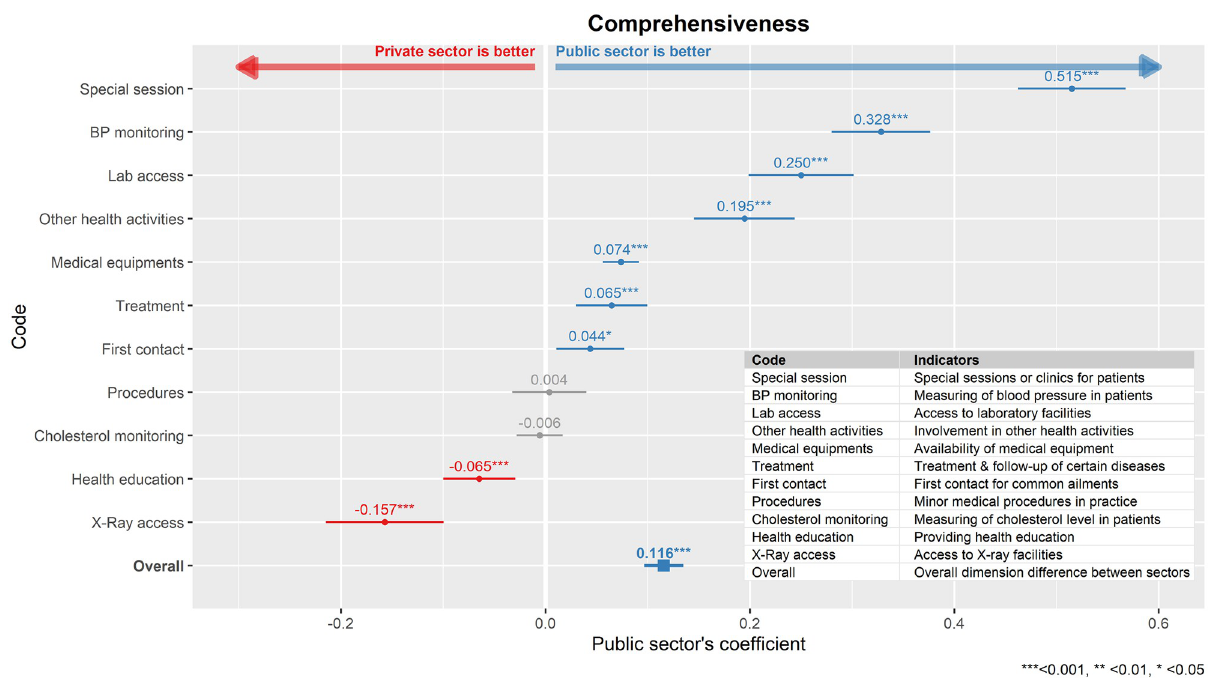
Fig 2. Comparison between public and private primary care clinics in the dimension of comprehensiveness of care. The public sector’s regression coefficient ( β public ) for each indicator model as well as overall dimension model was shown here together, with its 95% confidence interval.